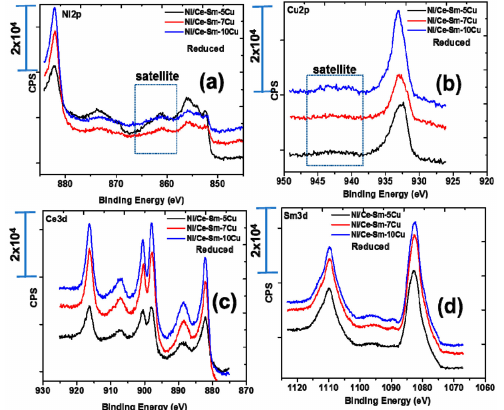
Figure 5. Core level spectra of: ( a ) Ni2p, ( b ) Cu2p; ( c ) Ce and ( d ) Sm3d, respectively, of the calcined Ni/Ce-Sm-xCu catalysts.